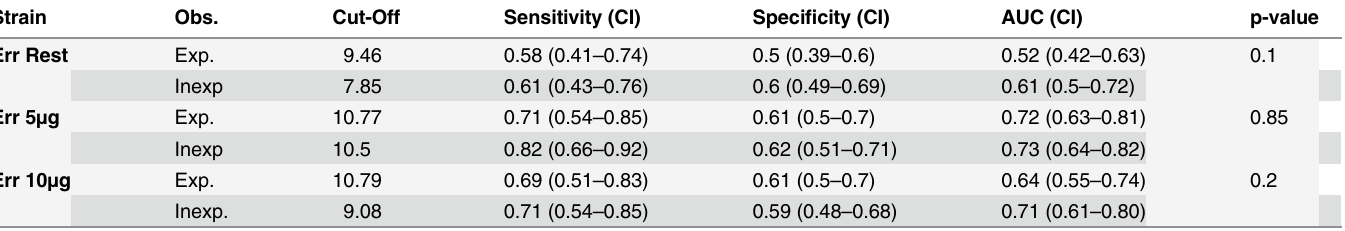
Table 5. The table shows the individual thresholds (cut-off) for left ventricular short-axis radial strain (Err) as assessed by one experienced (Exp.) and one inexperienced (Inexp.) observer (Obs.) at rest and with 5 and 10 μ g of dobutamine. Strain Obs.